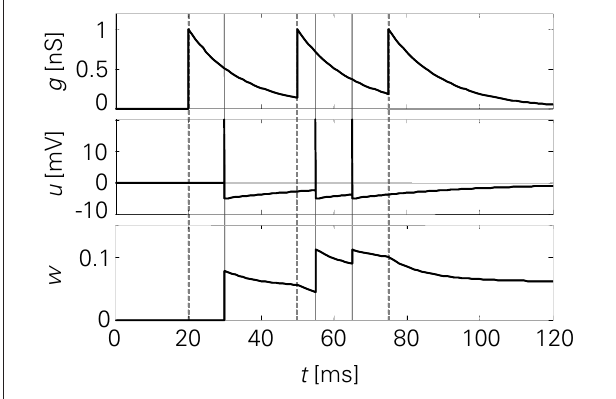
FigurE 3 | Progression of the conductance g , the membrane potential u and the synapse weight w for a sample spike pattern. Units were chosen to be in a biologically realistic range: ˆ G = 1nS, B = 1/(1 pC ). The remainder of the neuron and synapse parameters were taken from the Froemke 1 parameter set listed in Table 4